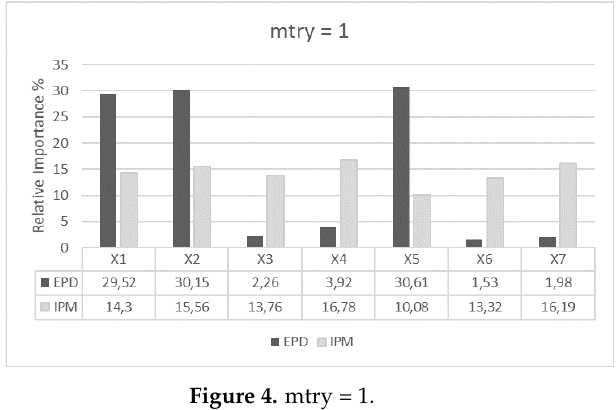
Figure 4. mtry = 1.